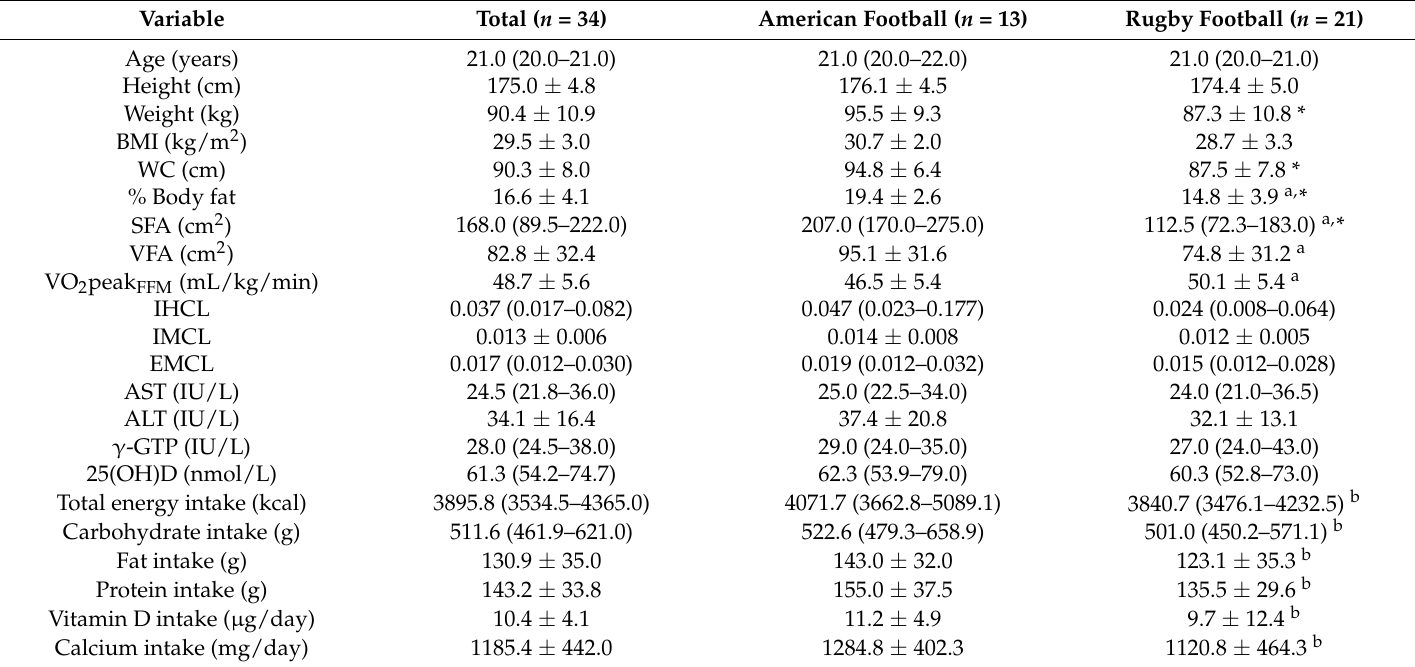
Table 1. Participant characteristics according to